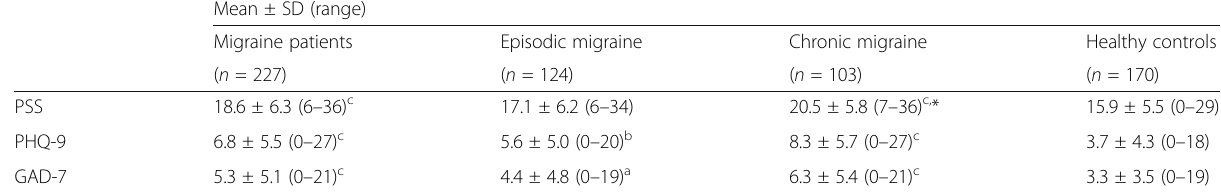
Table 2 Perceived stress, depression, and anxiety in migraine patients compared with controls Mean ± SD